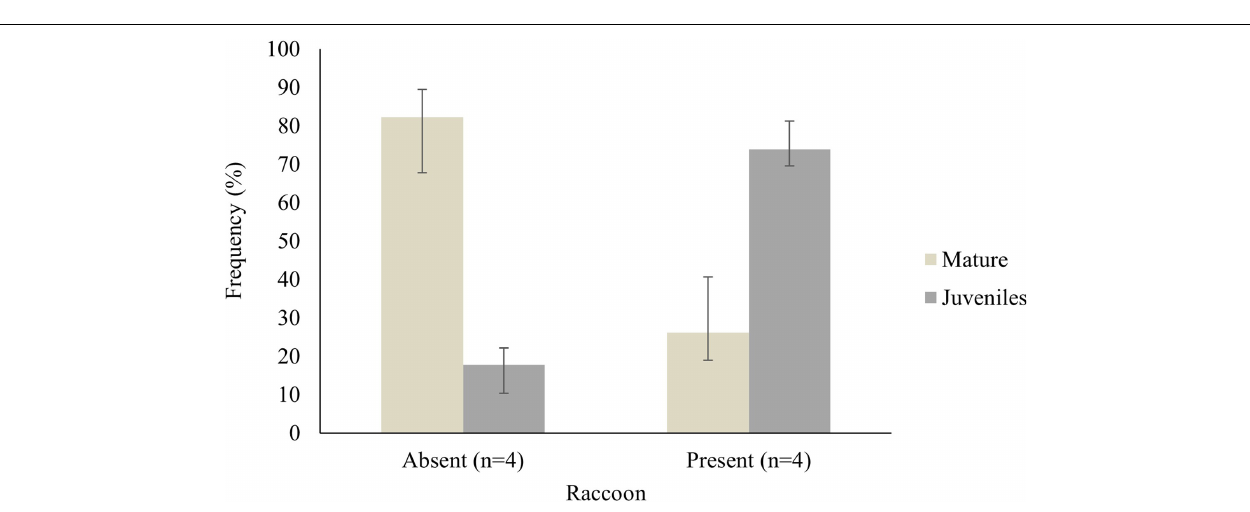
FIGURE 2 | Number of crayfish sampled in sites with or without raccoon in the Foreste Casentinesi, Monte Falterona, and Campigna National Park. The three sites sampled for the first time (Fosso Abetiolo, Fosso di Campo alla Sega, and Fiume d’Isola) were not considered in the graph. Bars represent medians + 1st and 3rd interquartiles.